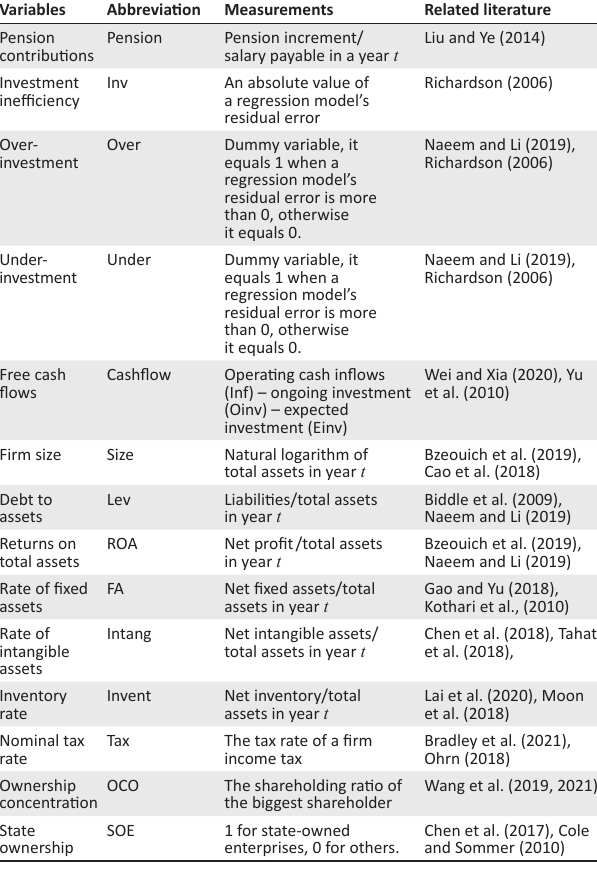
TABLE 3: Variable measurements based on related